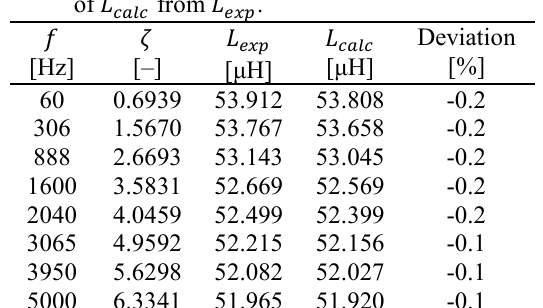
Table 3: Measured ( 𝐿 𝑒𝑥𝑝 ) and calculated ( 𝐿 𝑐𝑎𝑙𝑐 ) total inductances of a large rectangular loop coil at various frequencies 𝑓 , and the relative deviation of 𝐿 𝑐𝑎𝑙𝑐 from 𝐿 𝑒𝑥𝑝